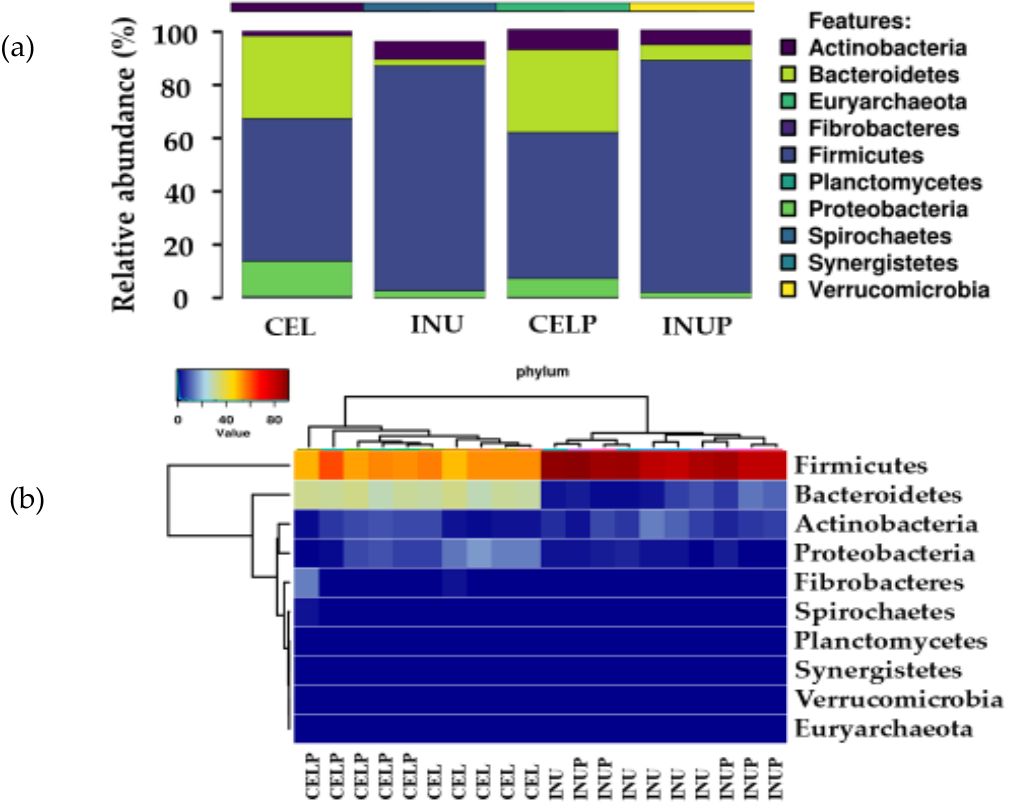
Figure 2. Relative abundances ( a ) and heat map ( b ) showing the predominant bacterial phyla of Firmicutes, Bacteroidetes and Actinobacteria during in vitro colonic fermentation of 3% cellulose (CEL), 3% cellulose + 0.16% PSP (CELP), 3% inulin (INU), and 3% inulin + 0.16% PSP (INUP). Table 1. Changes in bacteria populations and relative abundance of genus during in vitro colonic fermentation. Groups Two-Way ANOVA ( p -Value) CEL INU CELP INUP Fiber PSP Interaction Anaerobes (log 10 CFU mL − 1